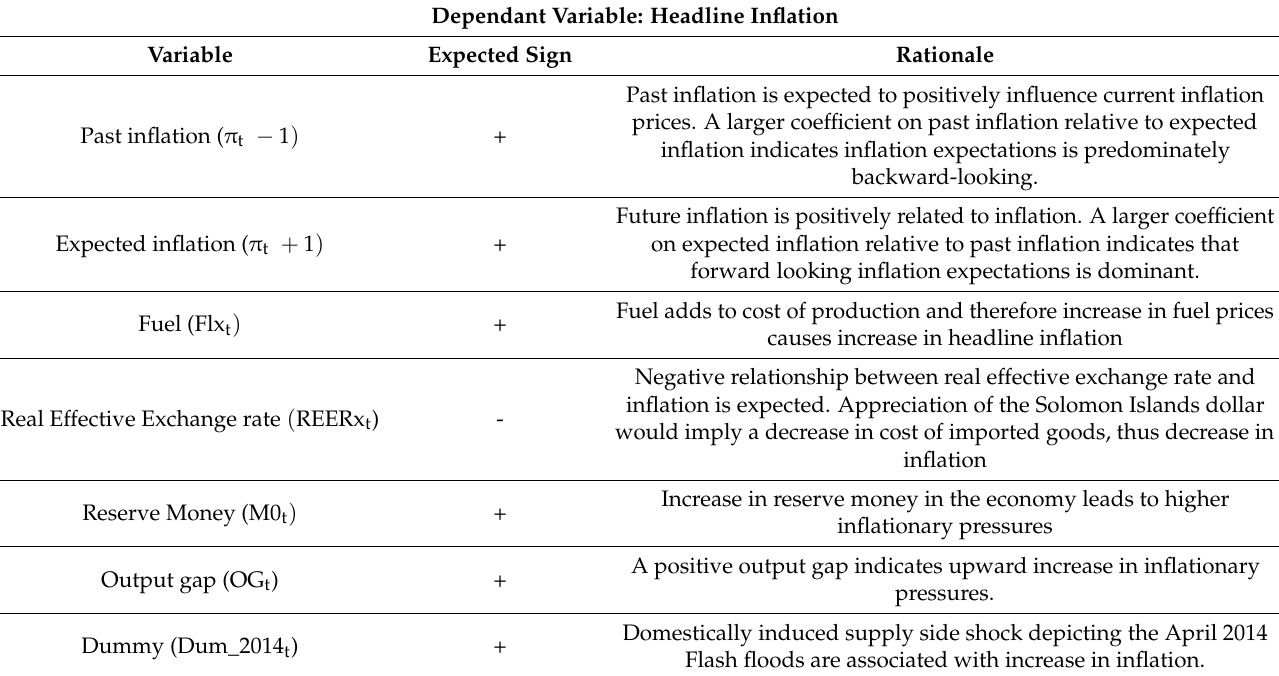
Table 3. Expected signs of coefficients of variables in the HNKPC